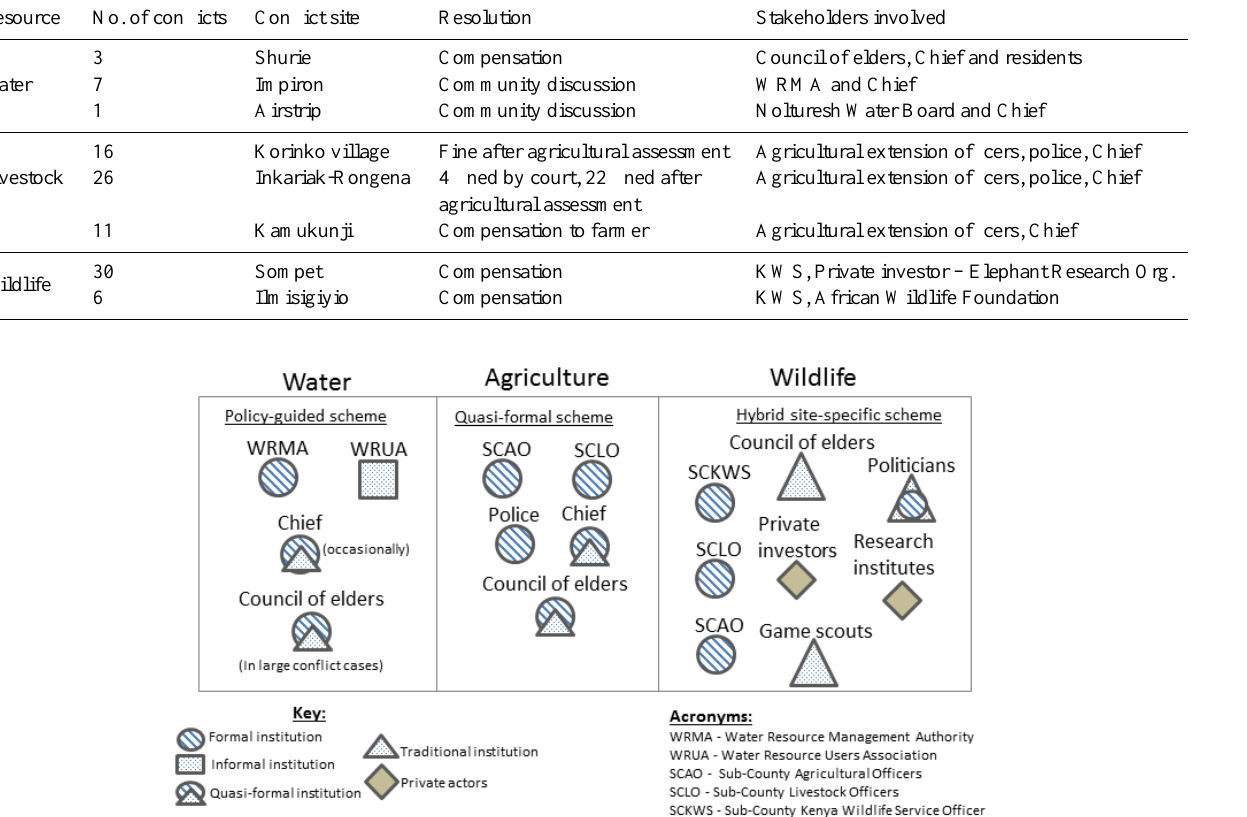
Table 1. The annual resource conflict report of Chief Leonard Kasine in-charge of Oloolopon Division in Loitoktok Sub-County (WRMA: Water Resources Management Authority, KWS: Kenya Wildlife Service).